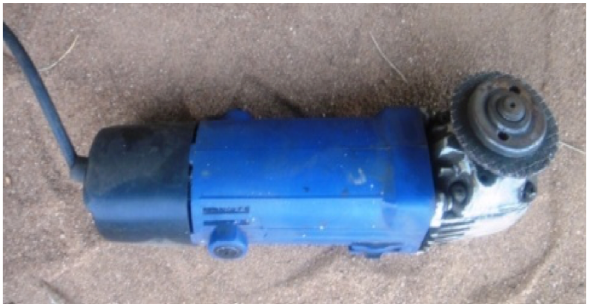
Figure 3 | Angle grinder (with a cutting disc). Photograph by Kingsley O. Emeriewen, 2012.